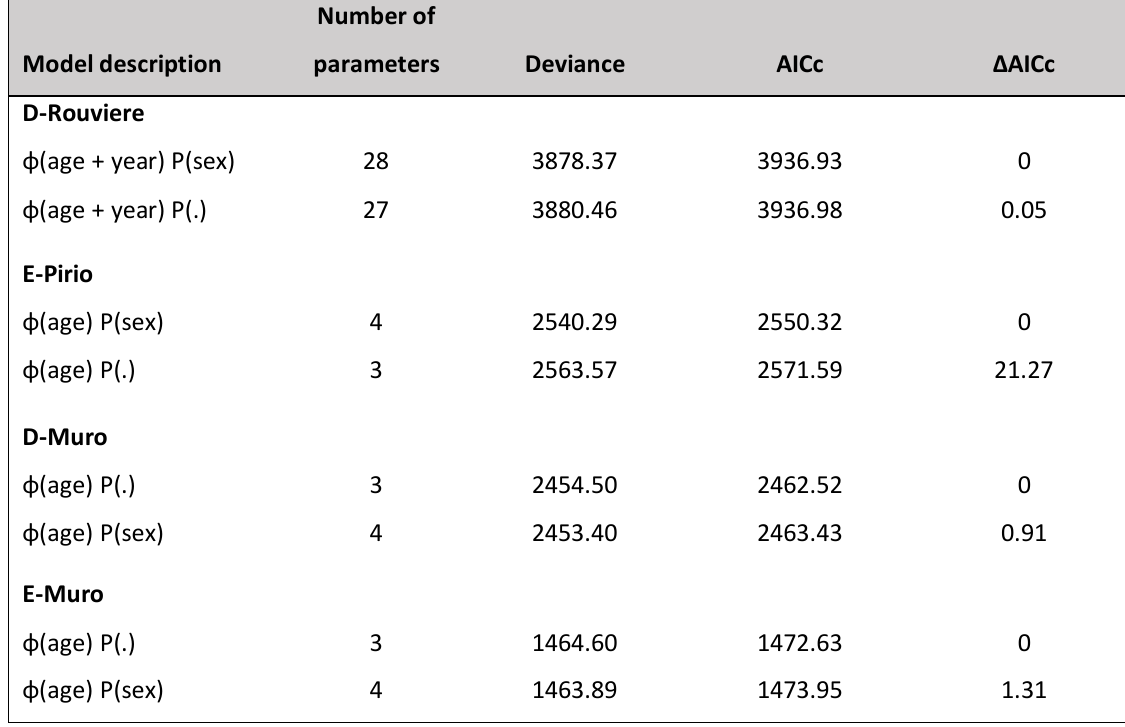
Table S2 : Comparison of models with and without a sex effect on recapture probabilities (P) in the four study populations of blue tits. In each p opulation, model structure for survival (φ) is based on results from Table 4 of the main